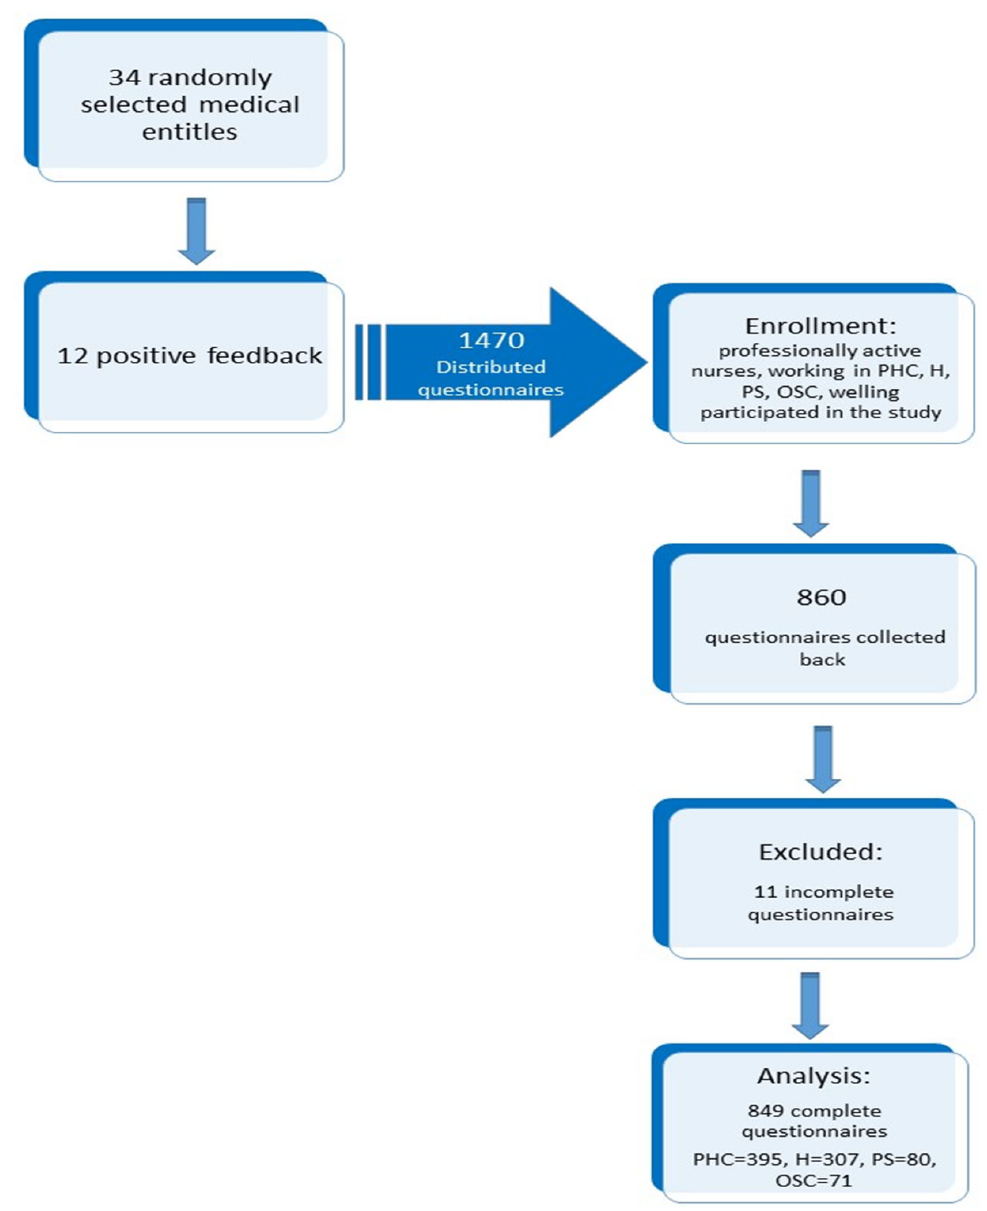
Figure 1. Flow chart demonstrating the selection of the study participants.